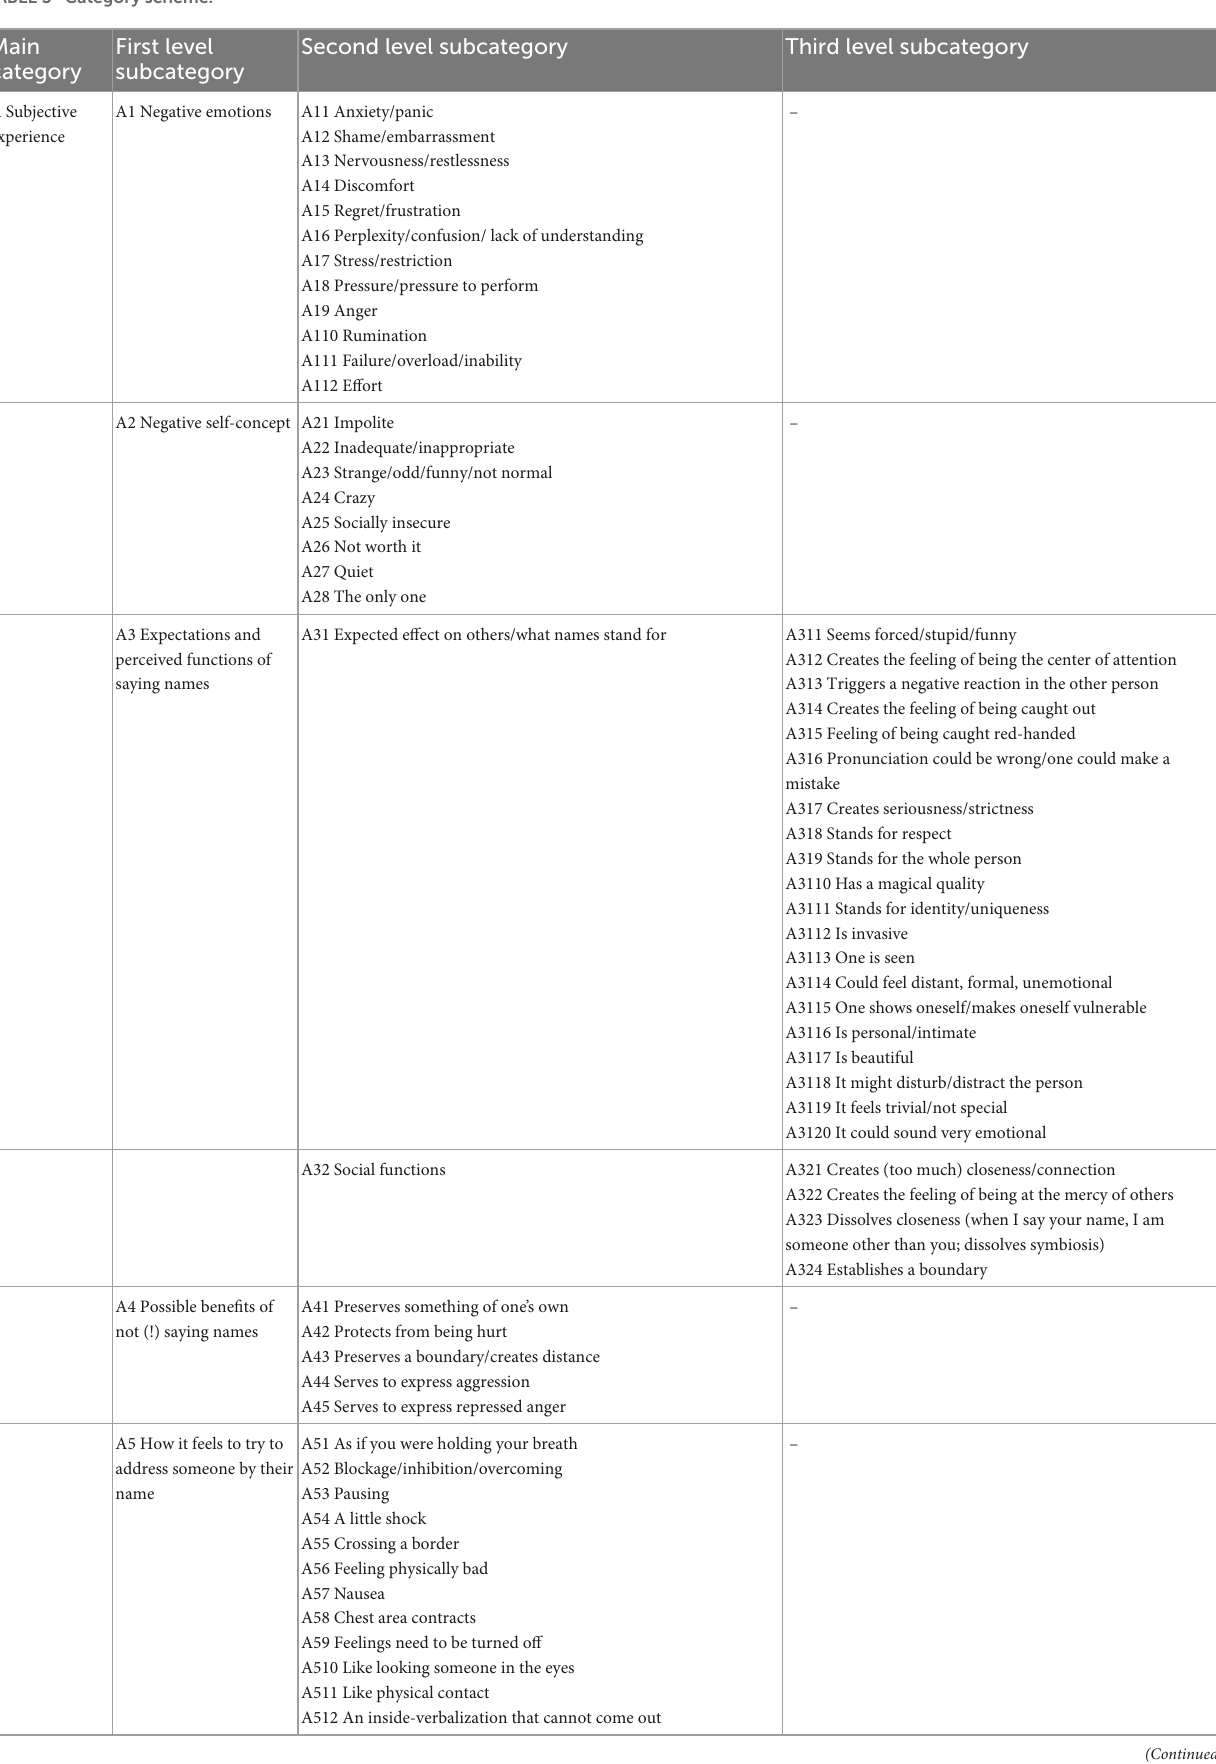
TABLE 3 Category